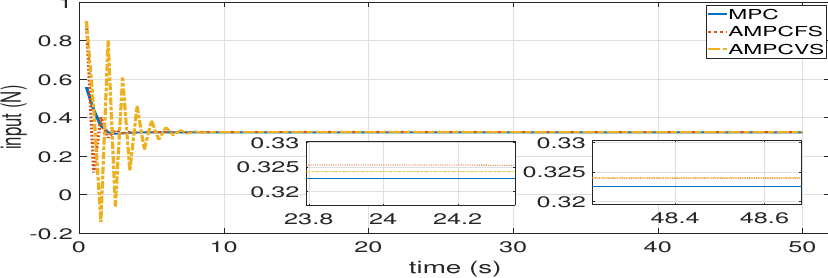
Figure 7. The control input of train with different MPC systems. The AMPCFS system is able to converge to the objective. Because the fixed step is constrained by the system error, the fixed step has to be set as a minimum value which is related to the superior of error. Compared with the AMPCFS, the AMPCVS system converges to the objective more quickly. That is because the step is variable so that it can become greater as long as constraint allows. It is illustrated in Figure 6 that the system error of AMPCVS converges to a neighborhood rounding zero in around 3 seconds (s) but AMPCFS spends around 50 s. This result can also be found from Figure 7. The control input of AMPCVS system tends to be stable. Then, the control input of AMPCFS tends to be as same as AMPCVS.